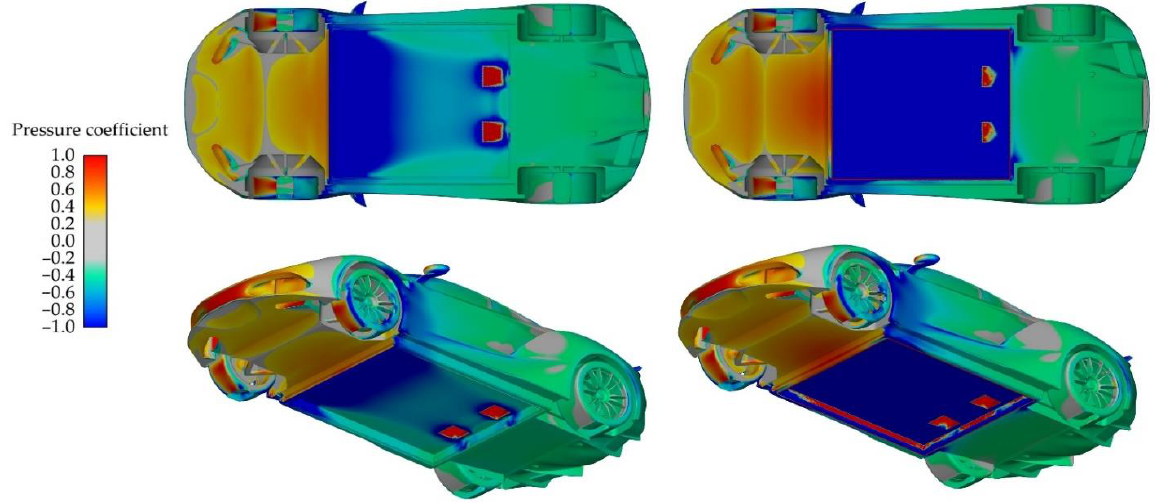
Figure 27. Pressure coefficient for the inlet speed of 20 m/s. On the ( left ), circulation fans generating air curtains were deactivated; on the ( right ) — they were active. Pathlines released from the front curtain fans can be seen in Figure 28 in a cross-section view. The curtain is sucked into the low-pressure zone and the proportion of air entering the chamber under the front nozzle increases for increasing